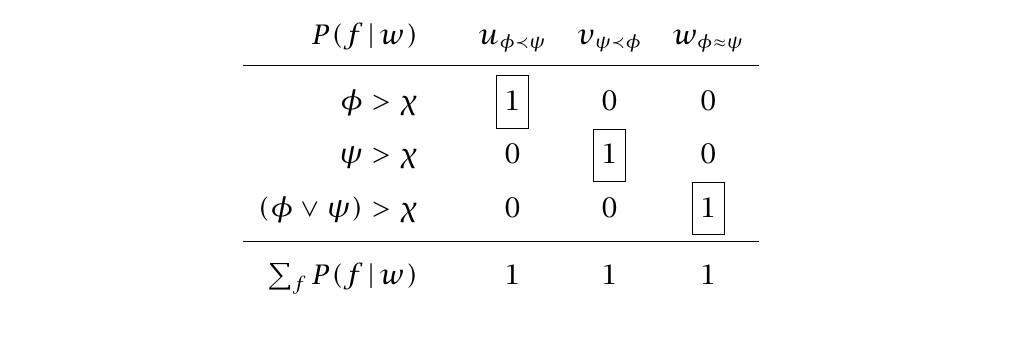
Figure 5 P(f | w) for 2 nd -level